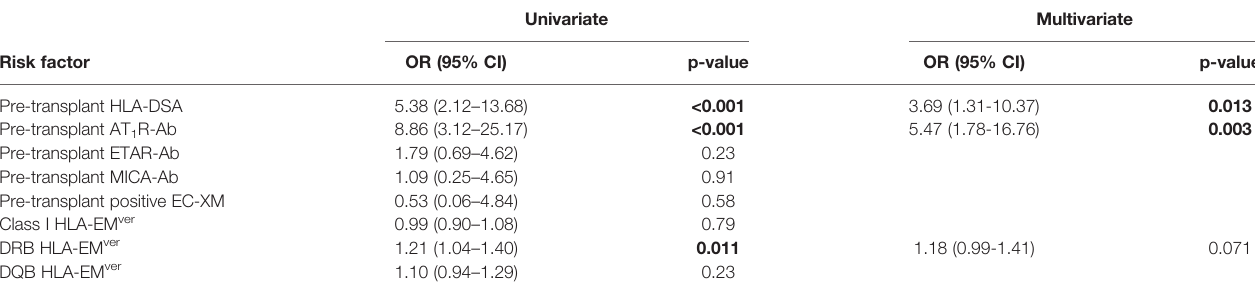
TABLE 4 | Logistic regression analysis of ABMR h DSA pos risk factors.